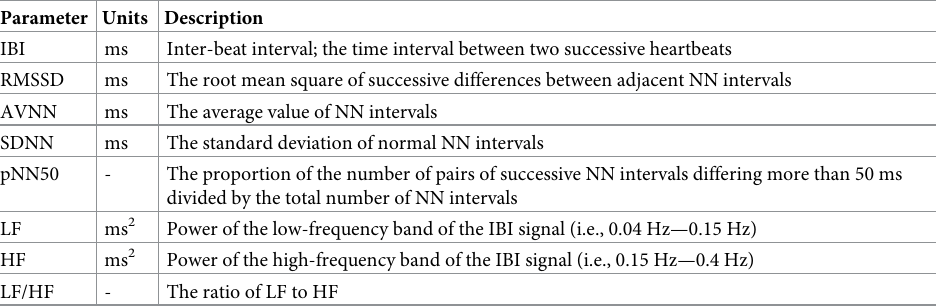
Table 1. A summary of HRV